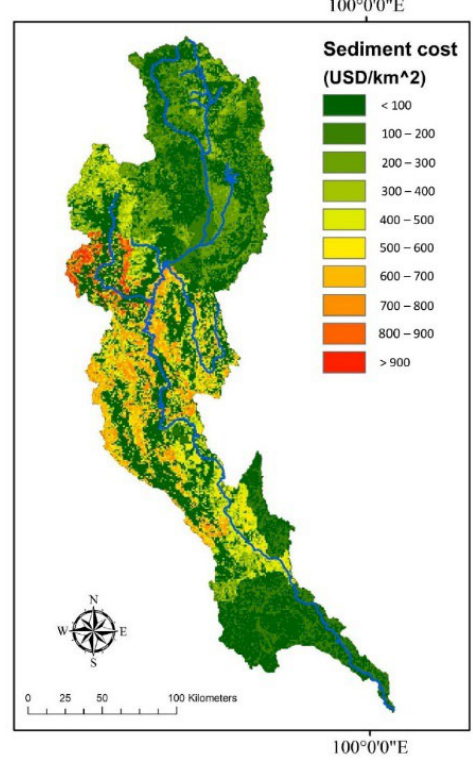
Figure 11. Potential of sediment costs.